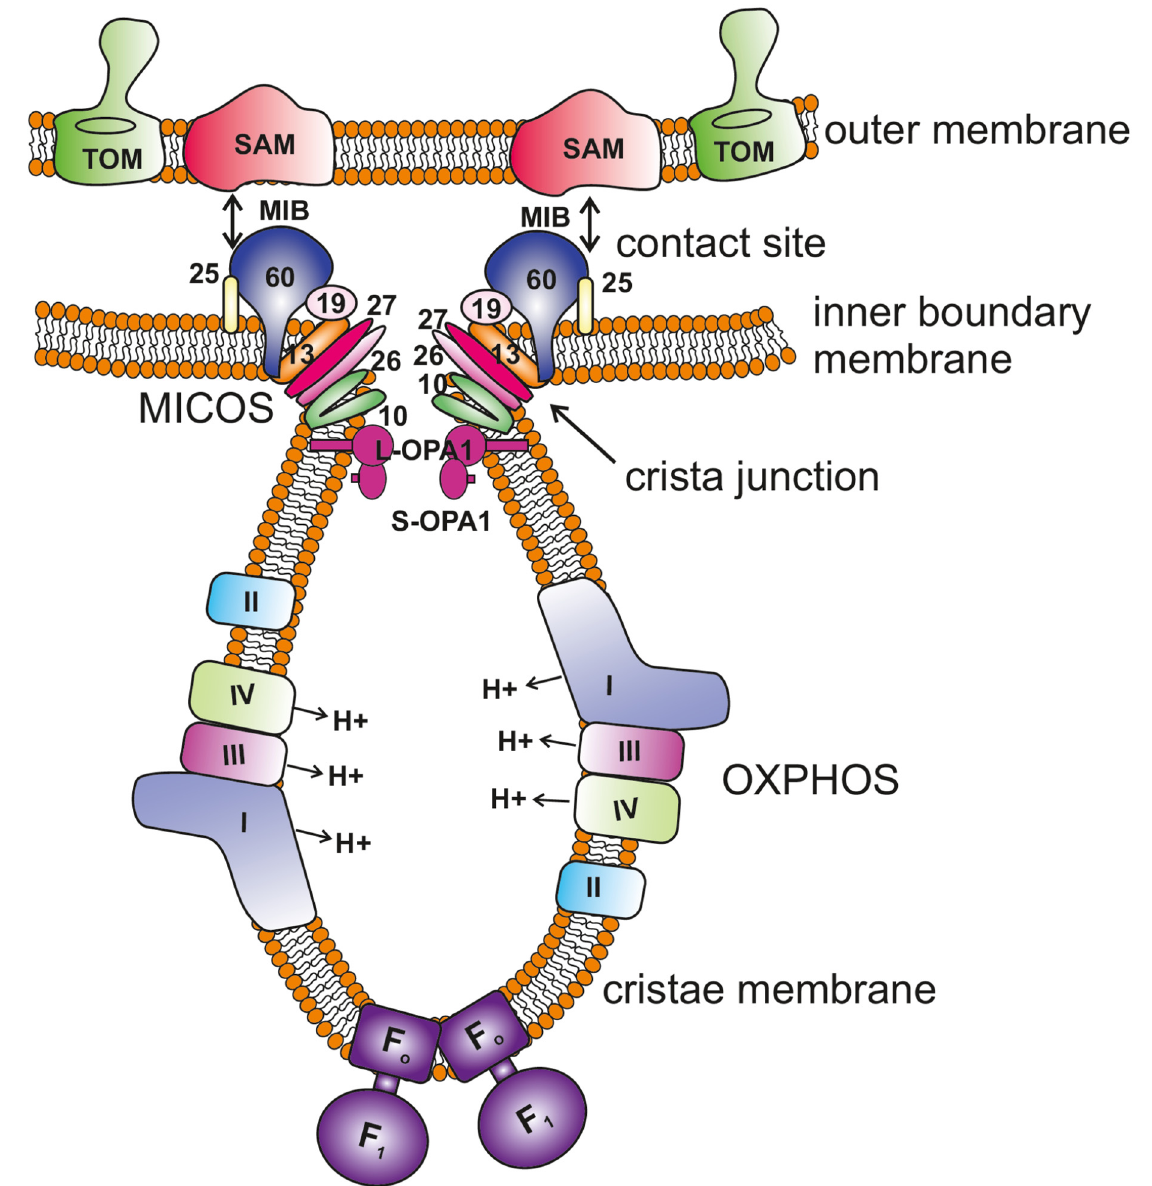
Figure 1. Key regulators of mitochondrial cristae organization. The scheme shows the organization of mitochondrial membranes where the cristae are formed by invagination of the inner membrane towards the matrix. The MICOS (mitochondrial contact site and cristae organizing system) complex resides at the crista junctions (CJs) and is composed of seven subunits, MIC10, MIC13, MIC19, MIC25, MIC26, MIC27 and MIC60 (only the numbers are depicted in the figure for the ease of legibility). MICOS is required to stabilize the CJs and form the contacts between the inner and outer membranes via interaction with the SAM (sorting and assembly machinery) complex. This interaction between MICOS and the SAM complex forms the larger complex called the mitochondrial intermembrane space bridging complex (MIB) that encompasses the intermembrane space. OPA1 is also enriched at the CJs, and interaction between membrane-bound long (L-) forms and soluble short (S-) forms is required to maintain the width of the CJs. F 1 F O ATP synthase plays an important role in the formation of positive membrane curvature at the tip/rim of cristae. The OXPHOS (oxidative phosphorylation) machinery resides in the cristae membrane.